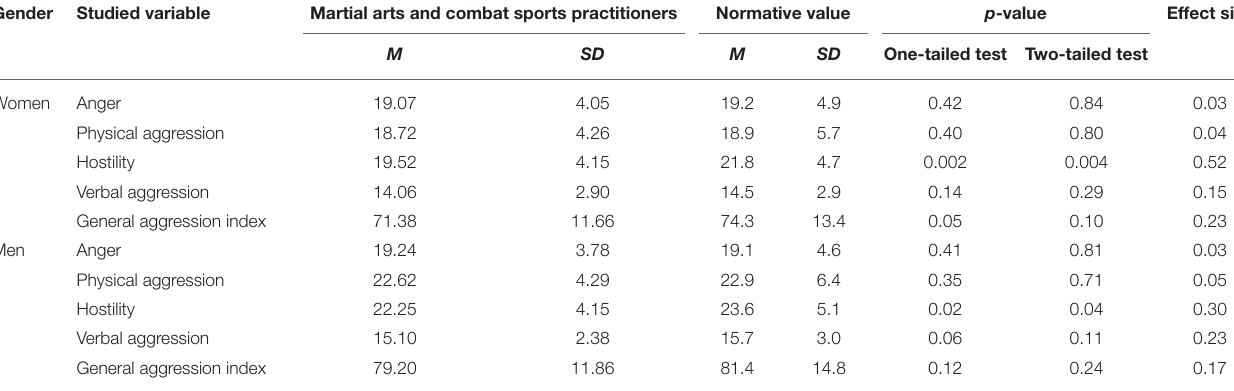
TABLE 2 | Comparison of the level of aggression dimensions between the respondents’ results and the normative value. Gender Studied variable